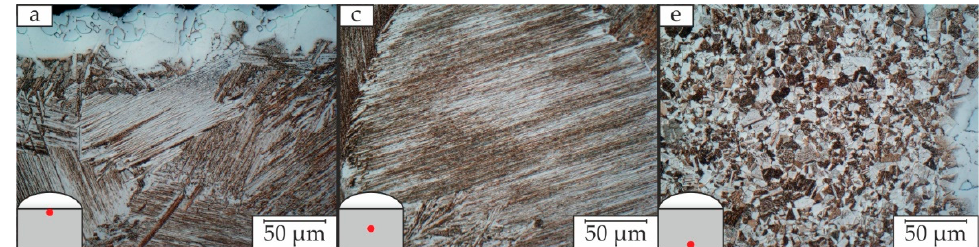
Figure A4. Microstructure in defined positions a, c and e according to Figure 1 (right) of a GE48 sample sintered at 1350 °C, with 2 min dwell time and 30 MPa pressure.